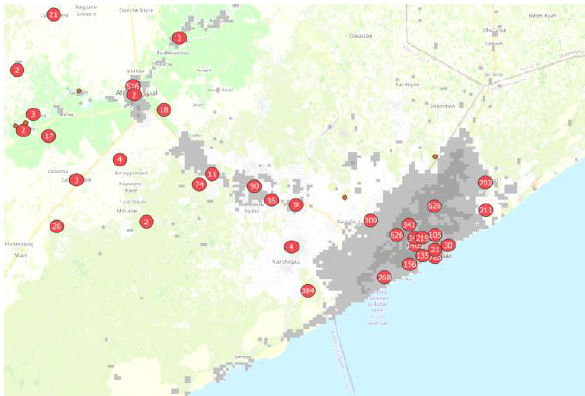
Figure 11. Classification of population change in Mogadishu for the period 2000-2015, and locations and number of conflicts Figure 11 shows the population change and conflicts locations from 2000to 2015. There is a significant increase in population change in this period. The number of conflicts is also on the substantial rise. In this period, the conflicts already spread out not only to the areas with significant population growth but also to the rural areas. Such an increase in conflict may be related to the rise of Al-Shabaab activities in